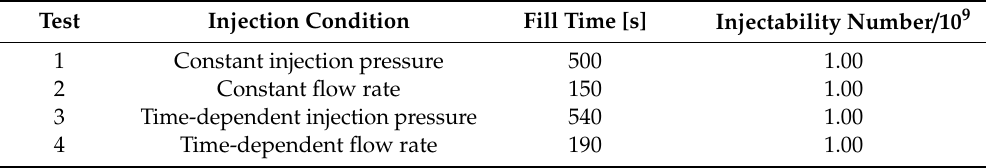
Table 1. Fill times and injectability numbers for unidirectional